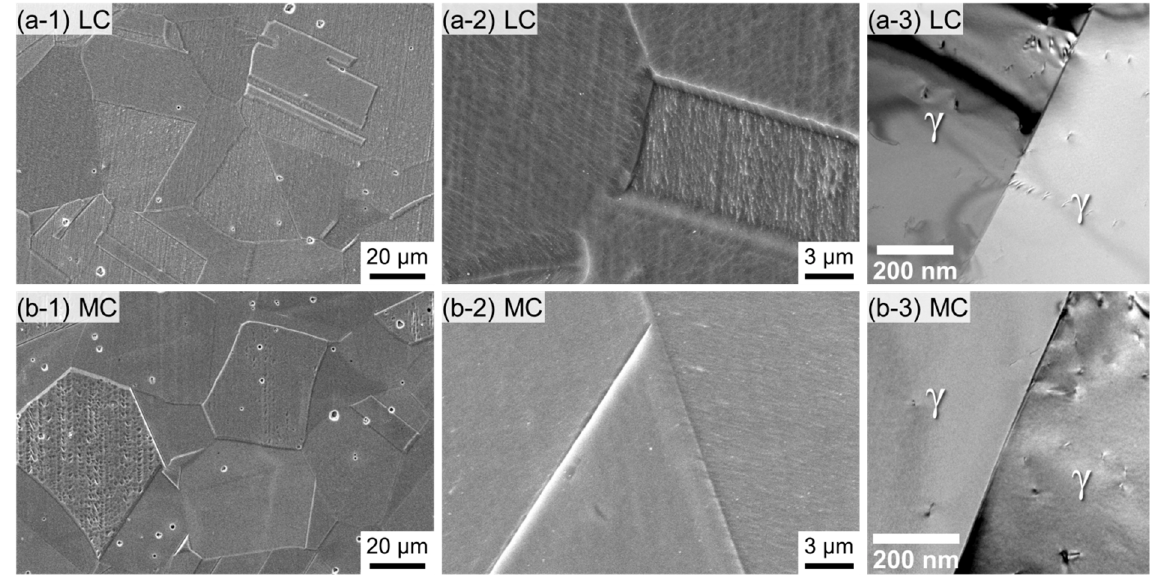
Figure 3. Microstructures of the ( a ) LC and ( b ) MC samples: Scanning electron microscopy (SEM) images taken at ( a-1 , b-1 ) low and ( a-2 , b-2 ) high magnifications, and ( a-3 , b-3 ) bright field transmission electron microscopy (TEM) images of the grain boundaries.